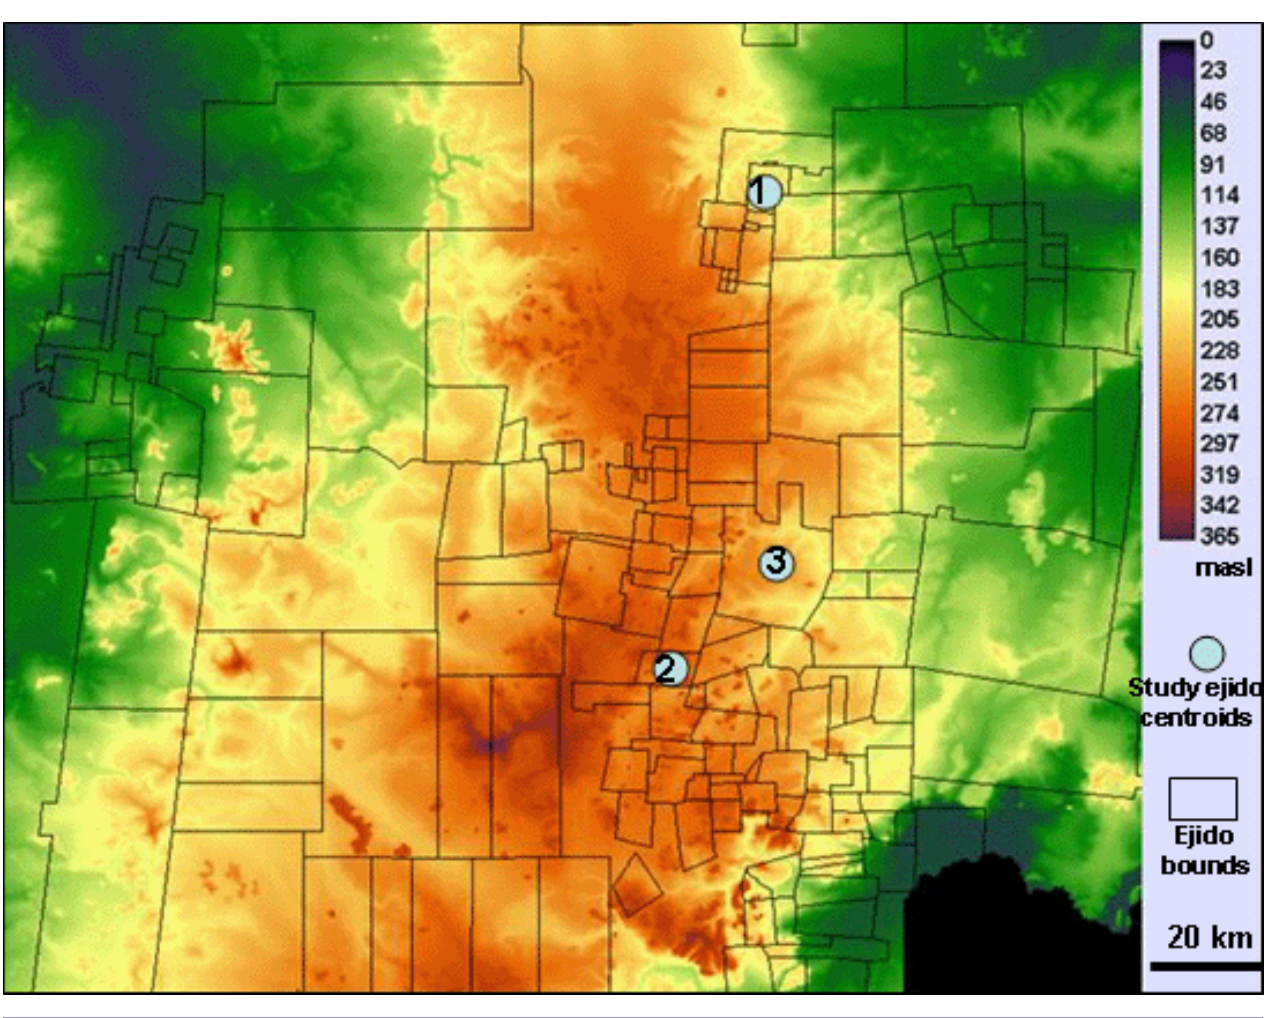
Fig. 2. Regional elevation above mean sea level (m) and study ejido locations. Polygons represent boundaries of ejidos in the